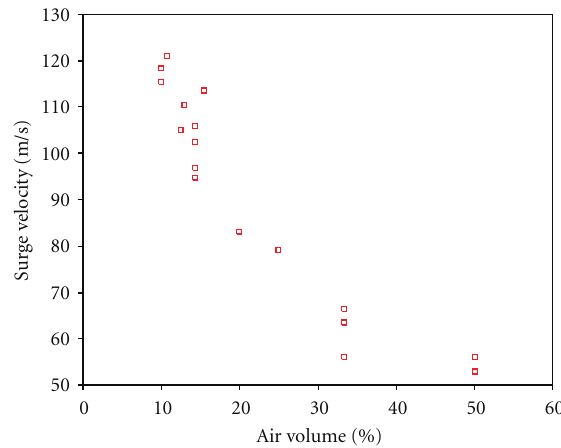
Figure 1: 2-D scatter diagram of surge wave speed for water pipeline with free water bubble.